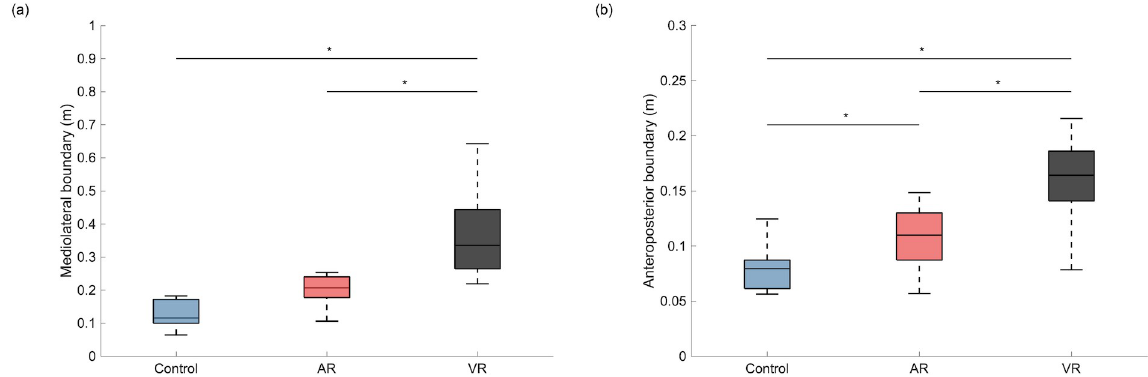
Fig 2. The group average and standard deviation of the (a) mediolateral and (b) anteroposterior boundary of the center of pressure ellipse under different walking conditions. AR: augmented reality; VR: virtual reality. Asterisk ( � ) denotes p < 0.05 in the corresponding pairwise